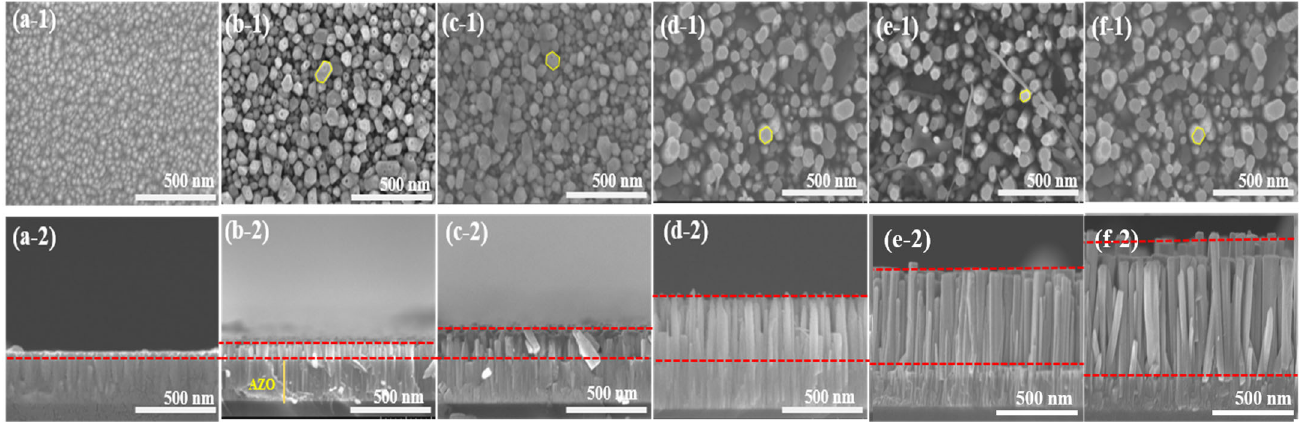
Figure 2. SEM images of ZnO nanorods with diffraction reaction times by CBD method: top views